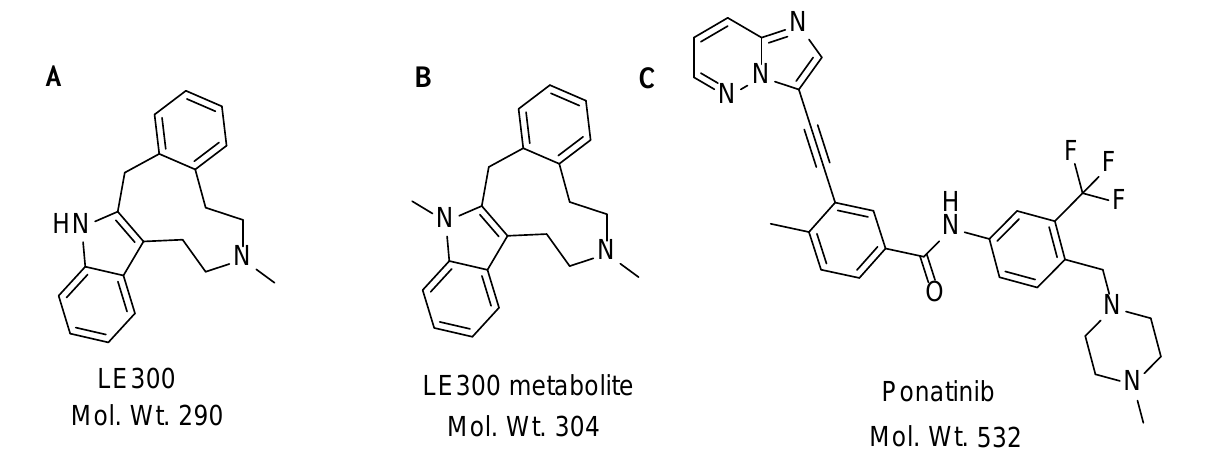
Figure 1. Chemical structures of LE300 ( A ), MLE300 ( B ), and Ponatinib ( C ). Methylation is a relatively minor conjugation pathway in drug metabolism, but it is very important in the biosynthesis of endogenous compounds, such as epinephrine and melatonin; and in the catabolism of biogenic amines, such as dopamine, serotonin, and histamine. In many cases, this conjugation results in compounds with decreased biological activity [5]. Methylation is a two-step process. First, the methyl-transferring coenzyme, S-adenosylmethionine (SAM), is biosynthesized mostly from methionine in a reaction catalyzed by methionine adenosyltransferase. Then, the SAM is utilized in the transfer of the activated methyl group to the acceptor molecule (LE300), as shown in Figure 2. Heterocyclic nitrogen atoms molecule such as LE300 are susceptible to N-methylation in human results in compounds with decreased biological activity.